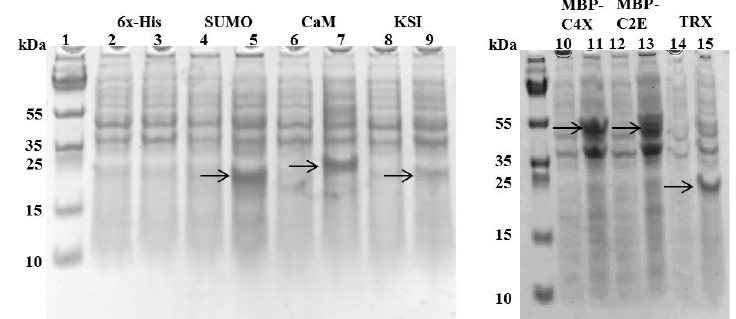
Figure 2. SDS-PAGE showing the expression of different tags with MIP-3 α constructs after 4 h of IPTG induction at 37 ◦ C. Even-numbered lanes show the cultures before IPTG induction, odd-numbered lanes show the induced constructs of pET19b-6 × His-MIP-3 α (Lanes 2–3), pET-SUM0-MIP-3 α (Lanes 4–5), pET15b-CaM-MIP-3 α (Lanes 6–7), pET19b-KSI-MIP-3 α (Lanes 8–9), pMAL-C4X-MIP-3 α (Lanes 10–11), pMAL-C2E-MIP-3 α (Lanes 12–13), and pET32a-TRX-MIP-3 α (Lanes 14–15). The bands observed for MIP-3 α attached to different fusion proteins are indicated by the arrows.